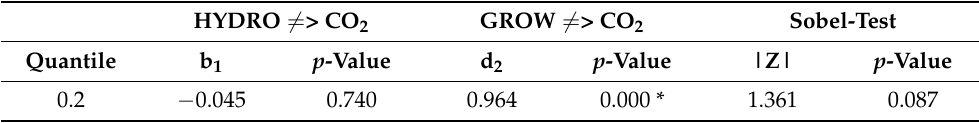
Table 3. The quantile results from HYDRO and GROW to CO 2 . HYDRO (cid:54) = > CO 2 GROW (cid:54) = > CO 2 Sobel-Test Quantile b 1 p -Value d 2 p -Value |Z| p -Value 0.2 − 0.045 0.740 0.964 0.000 * 1.361 0.087